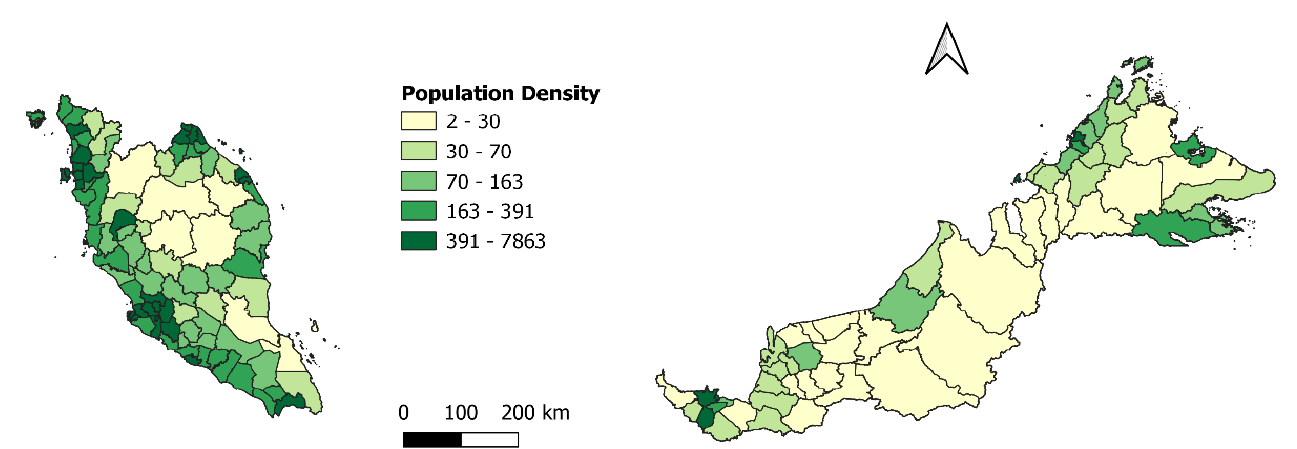
Figure A3. Population density by district, Malaysia (projected year 2020).